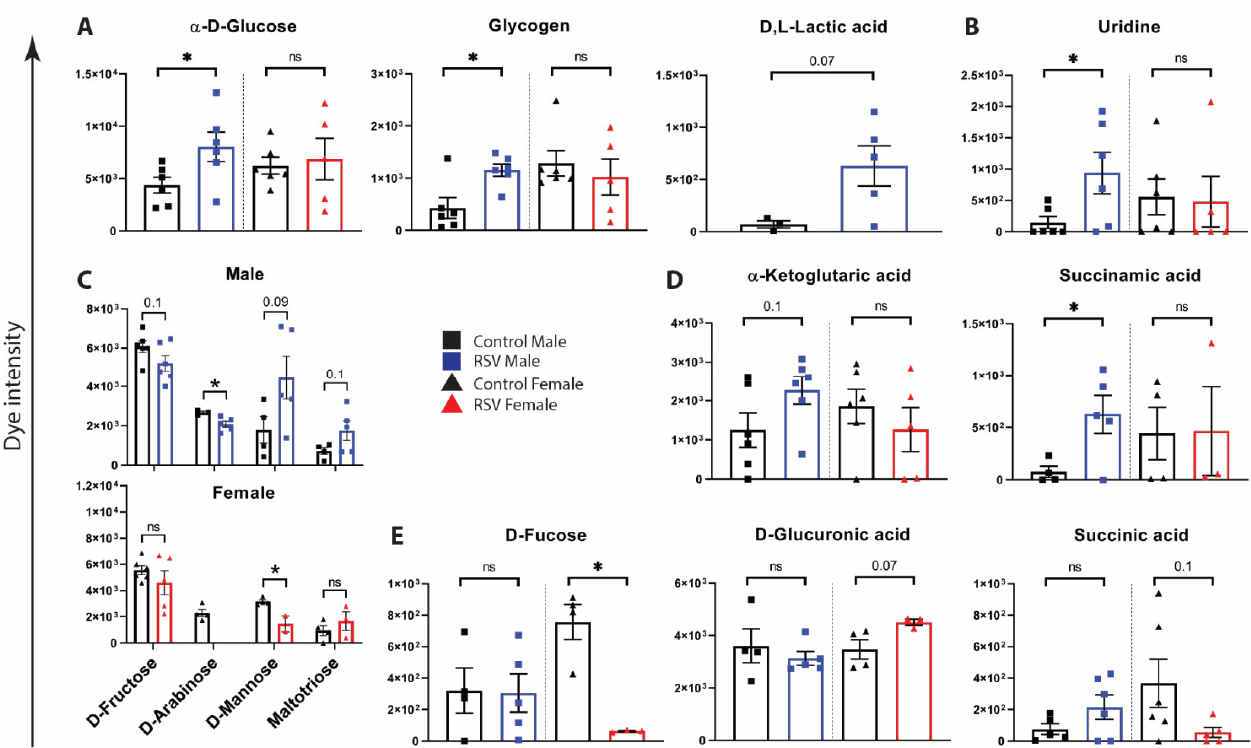
Figure 1. Principal component analysis showing overall differences in carbohydrate metabolism be ‐ tween NAECs collected at age 2 ‐ 3 years and compared between those with and without RSV infec ‐ tion during infancy and sex, measured as kinetic generation of NADH in a redox colorimetric Biolog assay. Aside from the effect of RSV, note significant separation of male and female healthy control clusters along principal component 1 (horizontal axis). All donors were equalized in culture density, passage, and treatment timelines.